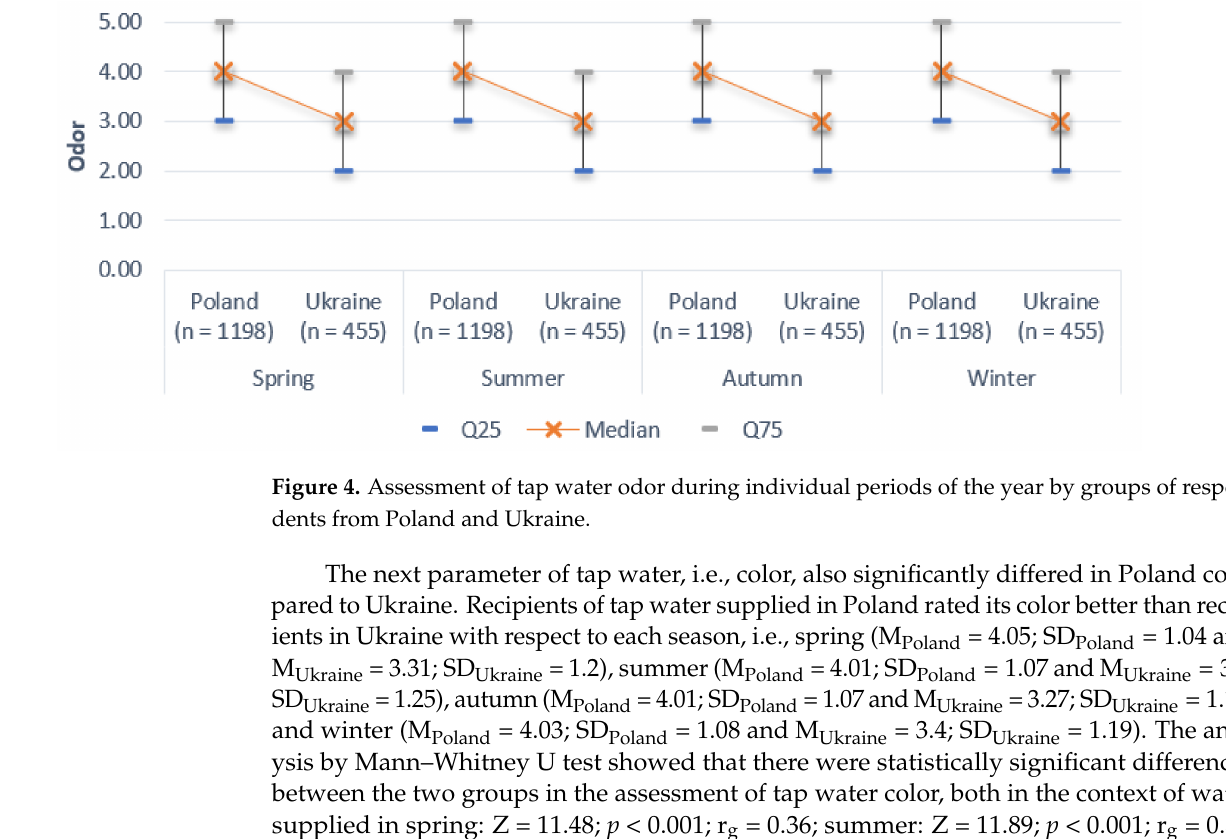
Table 10. Comparison of groups of respondents from Poland and Ukraine in terms of evaluation of tap water color during individual periods of the year. GlassMean ± Stand. Dev.